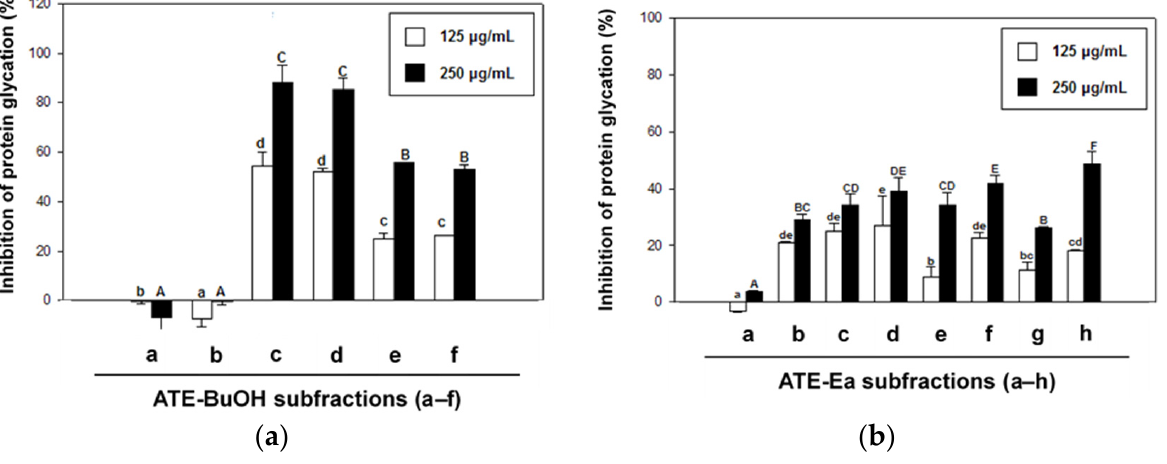
Figure 4. Effects of ATE-BuOH ( a ) and ATE-Ea ( b ) subfractions on glucose-mediated development of fluorescence of AGEs (BSA-glucose assay). Results are means ± SD for n = 3. Groups with different letter superscripts are significantly different ( p < 0.05). a–h, treated with 125 μ g/mL; A–F, treated with 250 μ g/mL.